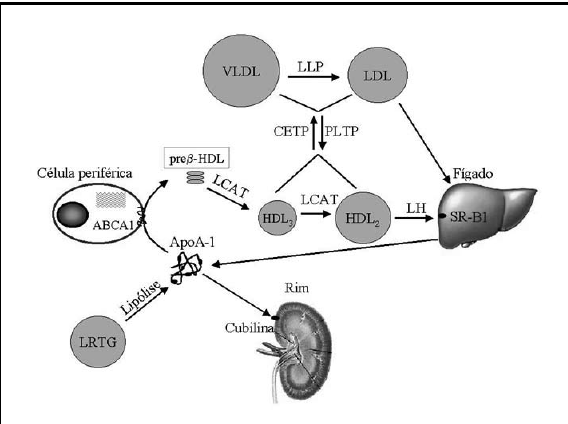
Figura 1 – Principais vias do transporte reverso do colesterol e metabolismo da HDL